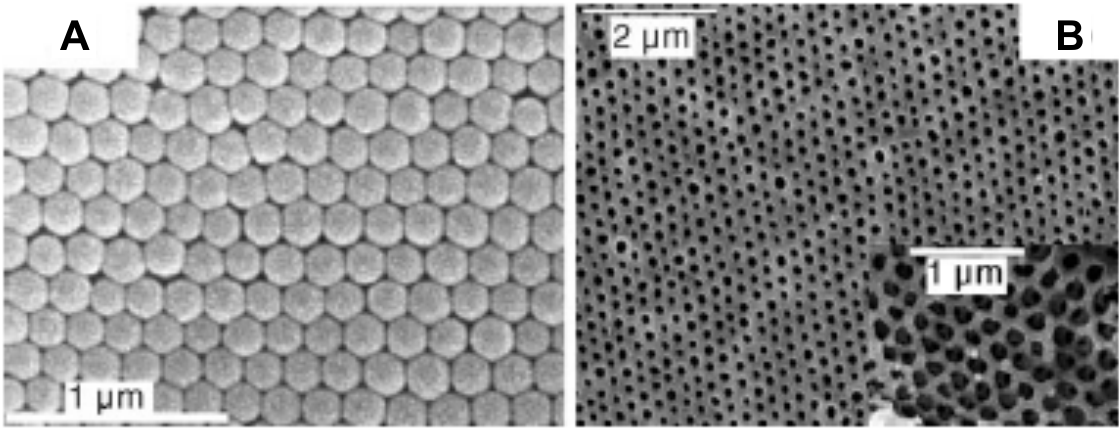
Figure 9. ( A) SEM image of colloidal crystal formed with SiO nm. (B) Top-view SEM image of the fabricated photonic MIP film. Inset: